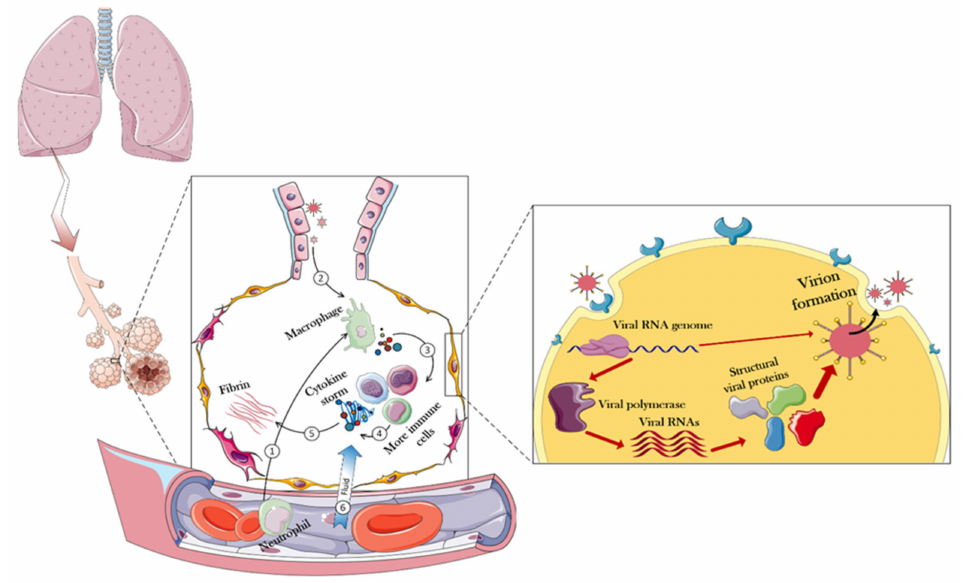
Figure 2. Immune responses and overall intracellular events triggered in the face of CoV-2. In normal conditions, immune cells enter the alveoli of the lungs through the blood. When CoV arrives in the alveolar compartment, these immune cells oppose them and eventually produce cytokines. Positively regulating, cytokines trigger more immune cells, eventually producing more cytokines. During these events, the fibrin of the alveoli increases, resulting in partial destruction and increased permeability of the alveoli. Consequently, fluid goes on the battlefield (alveoli) through the capillaries, causing destruction and edema of the infected lung. However, when a virus can compete with these challenges, it will be able to enter the host cell. In the host cell, the viral genome is generally released and the host equipment is used to replicate the viral particles. The following sections of the article provide more details in this